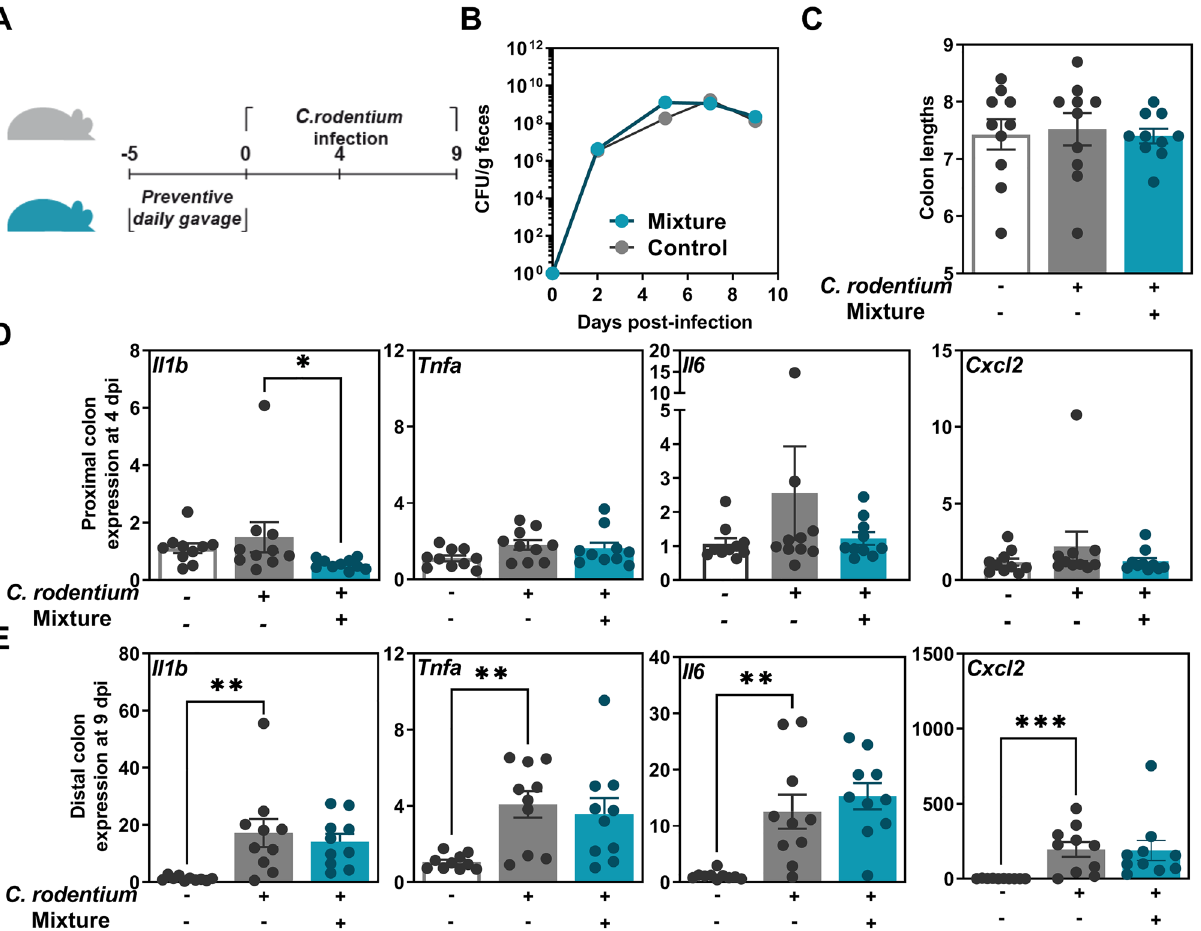
Figure 4. Capacity of the mixture to limit Citrobacter rodentium -induced colitis in C57BL/6J mice. ( A ) Experimental design. Mixture of three bacterial strains (5 × 10 8 CFU/day/mice, all strains were present in equal amount in the mixture) was daily administered by intragastric preventive gavage for 5 days (n = 10 per group). ( B ) C. rodentium burden, ( C ) Colon lengths. ( D ) qRT-PCR analysis of the expression of pro-inflammatory genes in the proximal colon of mice after 4 days post infection when compared to non-infected animals. ( E ) qRT-PCR analysis of the expression of pro-inflammatory genes in the distal colon of mice after 10 days post infection when compared to non-infected animals. Results from one experiment are expressed as relative gene expressions (2 −∆∆ct ) by comparing the PCR cycle thresholds (Ct) for the gene of interest and for the house keeping gene β-actin ( bact ), compared with control mice. * p < 0.05; ** p < 0.01, *** p <